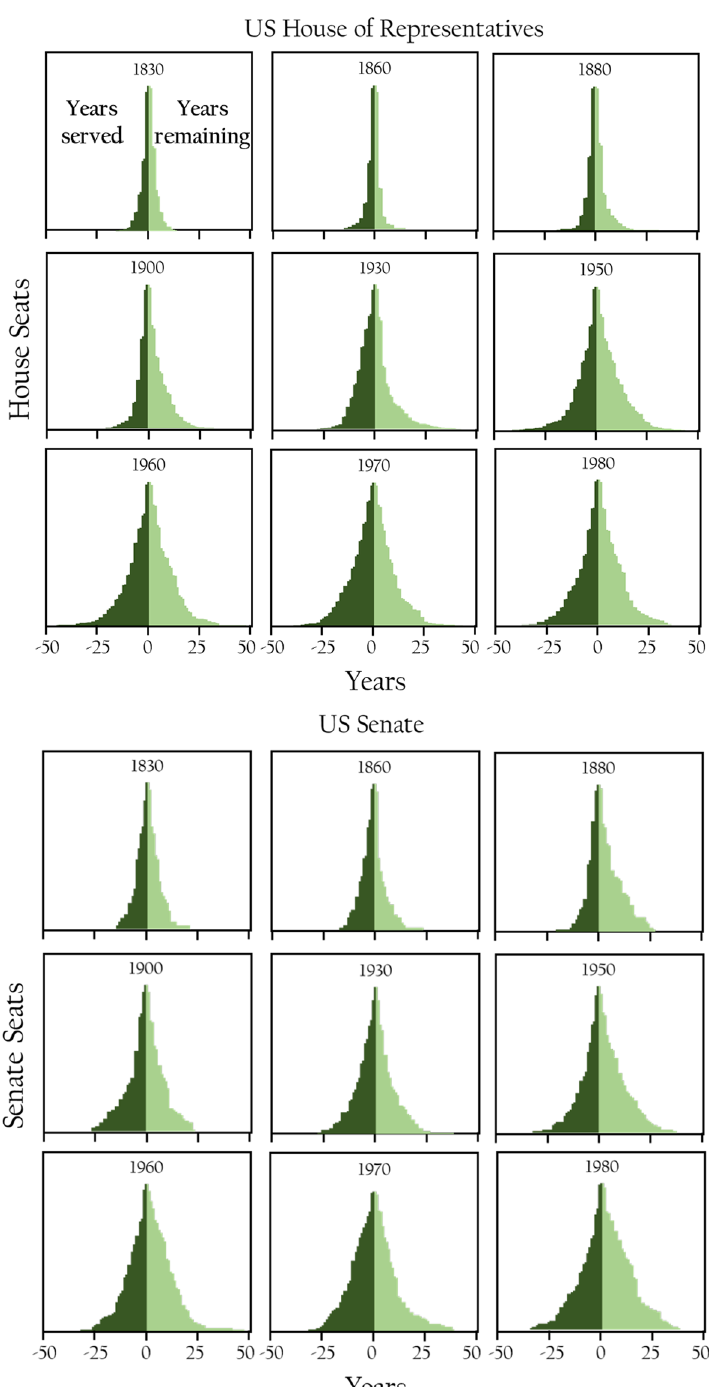
Fig. 4 Distributions of years served and years remaining for U.S. Senators normalized by number in selected years for the U.S. House (top panels) and Senate (bottom